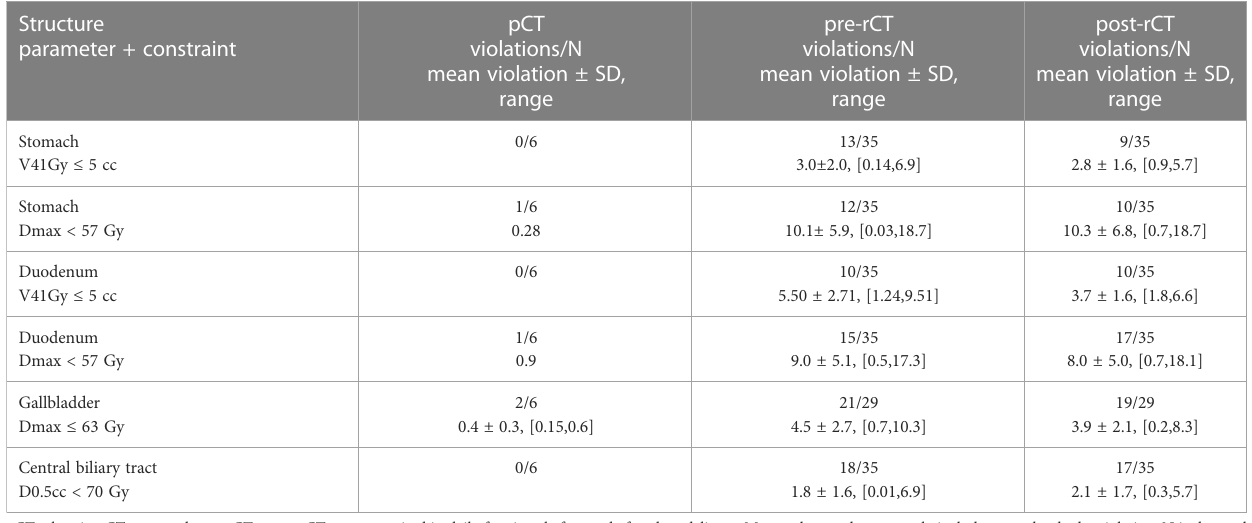
TABLE 2 OAR constraint violations in planning and in repeat CTs in the patient population.